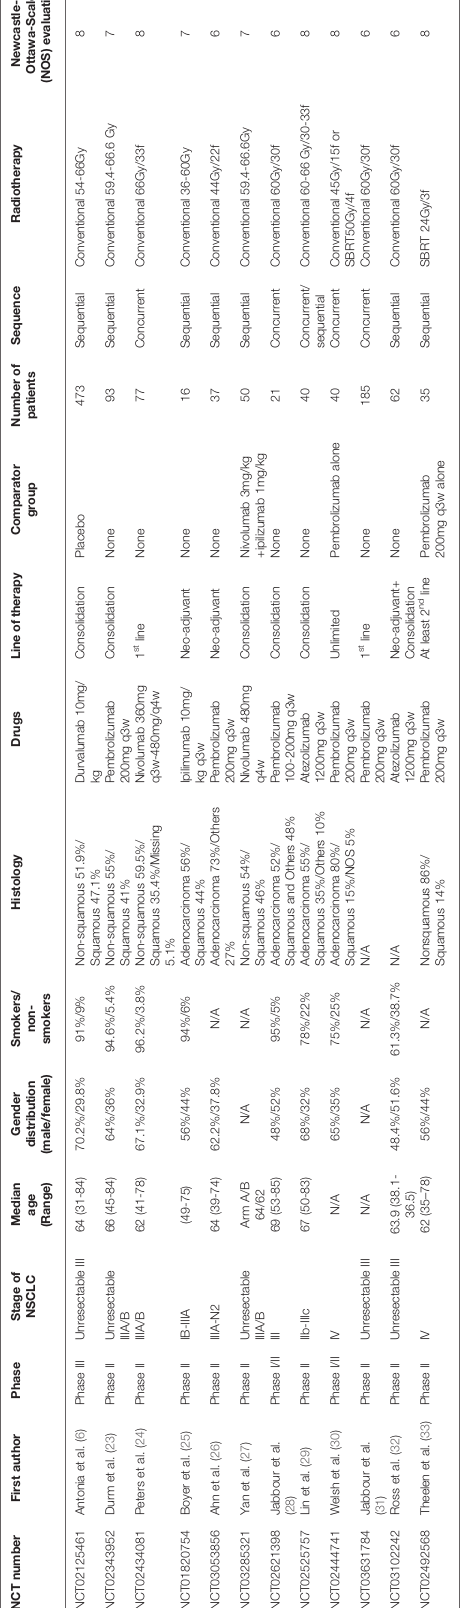
pneumonitis were shown in Supplementary Figure 1 . Among those who received ICIs and TRT, nausea and diarrhea (AEs related to the gastrointestinal tract) occurred in 29.1% and 15.8% of patients, respectively. Of note, the incidence of pruritus, dermatitis, rash, and thyroiditis was 12.4%, 11.2%, 13.4%, and 9.4%, respectively ( Table 2 ).